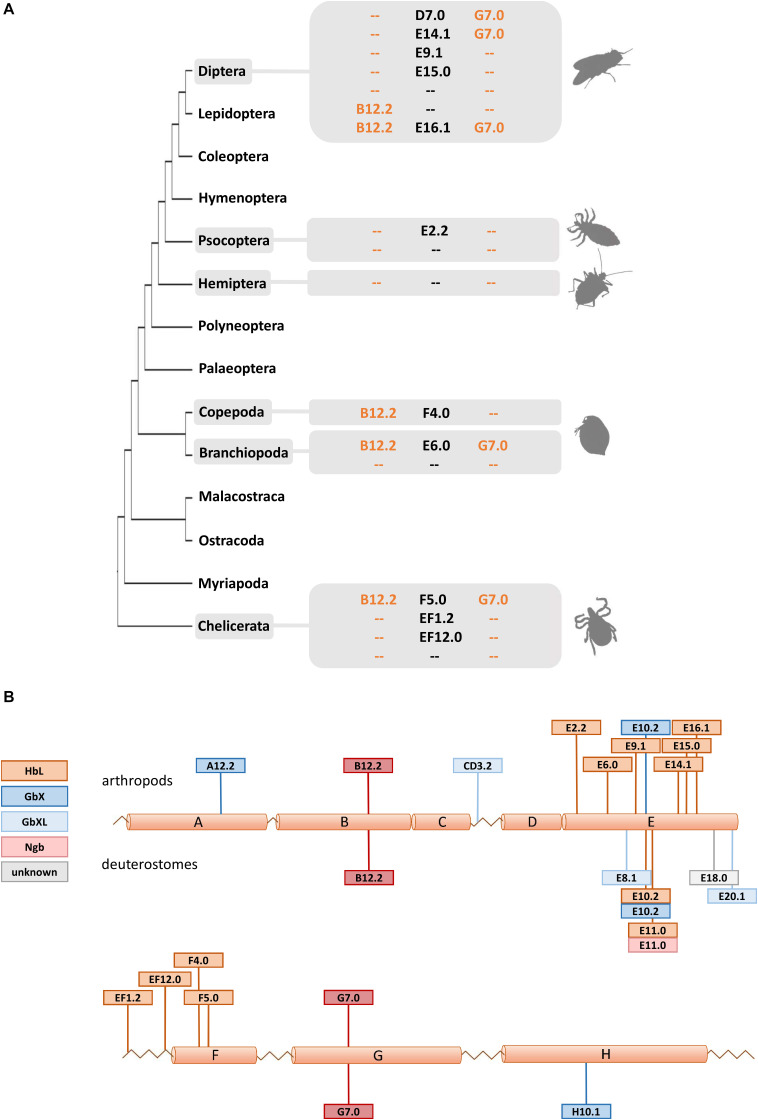
Intron evolution in arthropod globin genes. (A) The standard arthropod globin gene harbors the conserved intron positions named B12.2 and G7.0 (see text). Here we highlight that variable intron positions were often found in arthropod HbL genes suggesting multiple cases of intron loss and intron gain. (B) Summary of intron positions observed along the arthropod and deuterostome globin fold (with a helices A to H). Note the conservation of the B12.2 and G7.0 intron positions and the positional variability of introns interrupting the central part of the globin fold (a helices E and F).